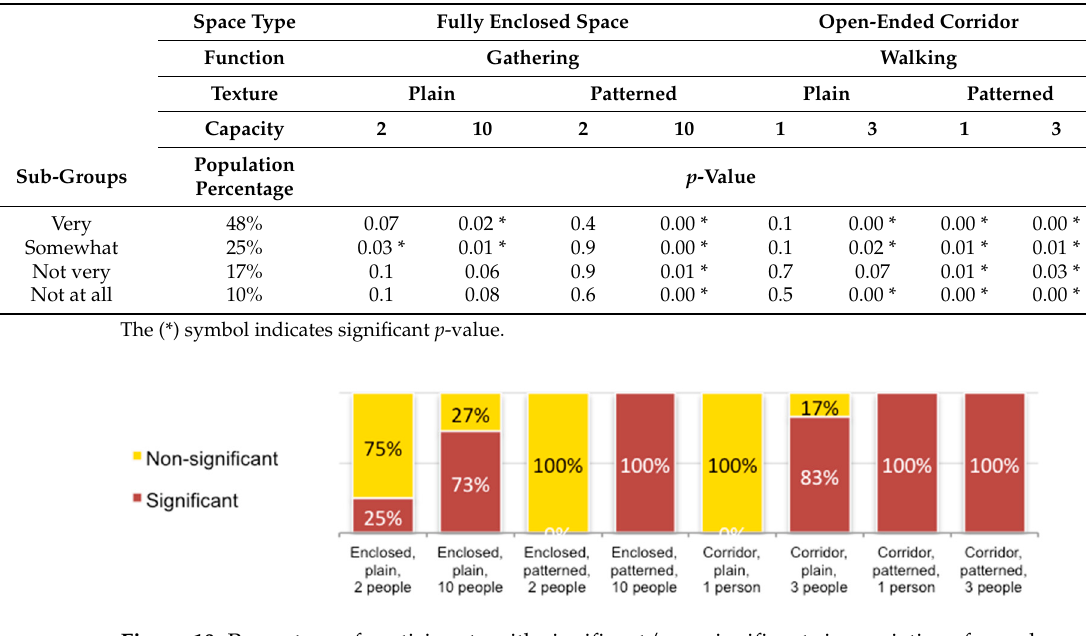
Table 8. Familiarity with 3D environments in the DT system perception filter and comparisons of space size variations between IVRIE and DT systems.